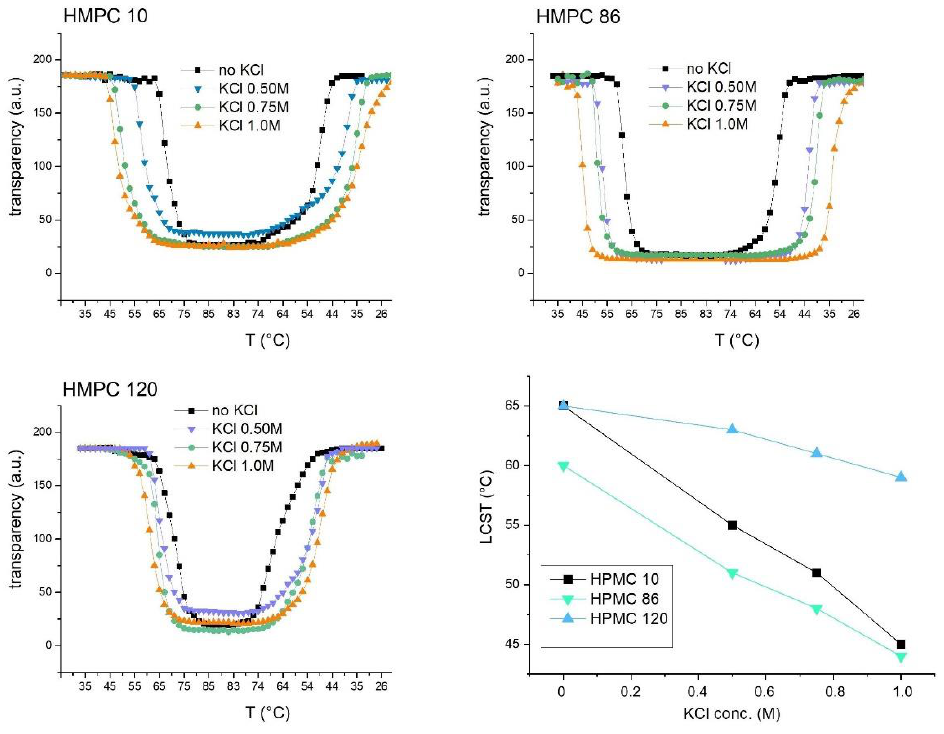
Figure 5. Transparency as a function of temperature during a thermal cycle from heating to cooling at 1 ◦ C/min for 1 wt % aqueous solution of HPMC without and with the addition of KCl. In the last frame, the variation in LCST without and in the presence of increasing concentration of KCl is re- ported.